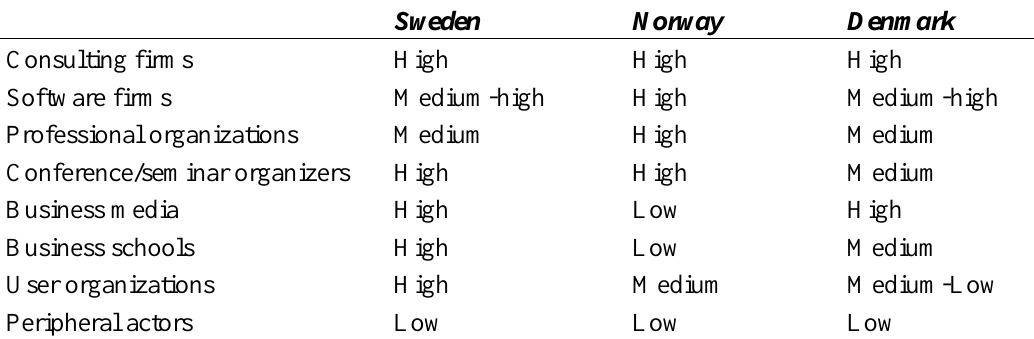
Table 5. The relative importance of the various actors 1992–2011.